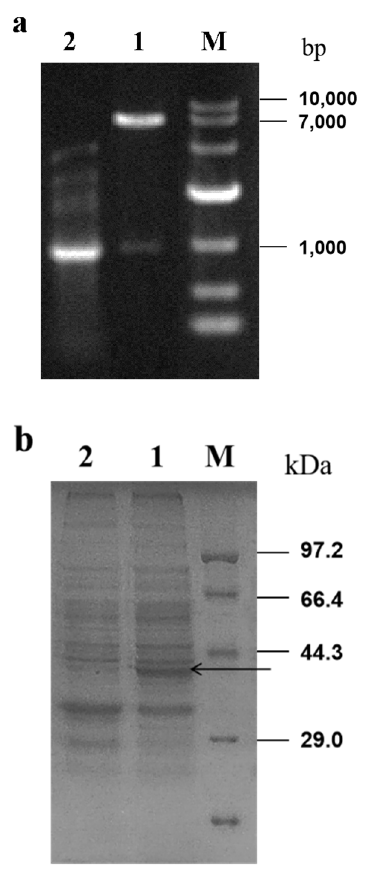
Figure 3. Cloning and expression of collagenase. ( a ) Electrophoresis gel of the double-digested plasmid from B. subtilis WB600 to show the presence of the col gene. M, DNA ladder; lane 1, recombinant plasmid digestion; lane 2, recombinant plasmid PCR. ( b ) The recombinant collagenase was successfully expressed. M, molecular weight marker; lane 1, B. subtilis WB600/pP43NMK- col fermentation supernatant, the arrow points to the target protein; lane 2, B. subtilis WB600/pP43NMK fermentation supernatant.